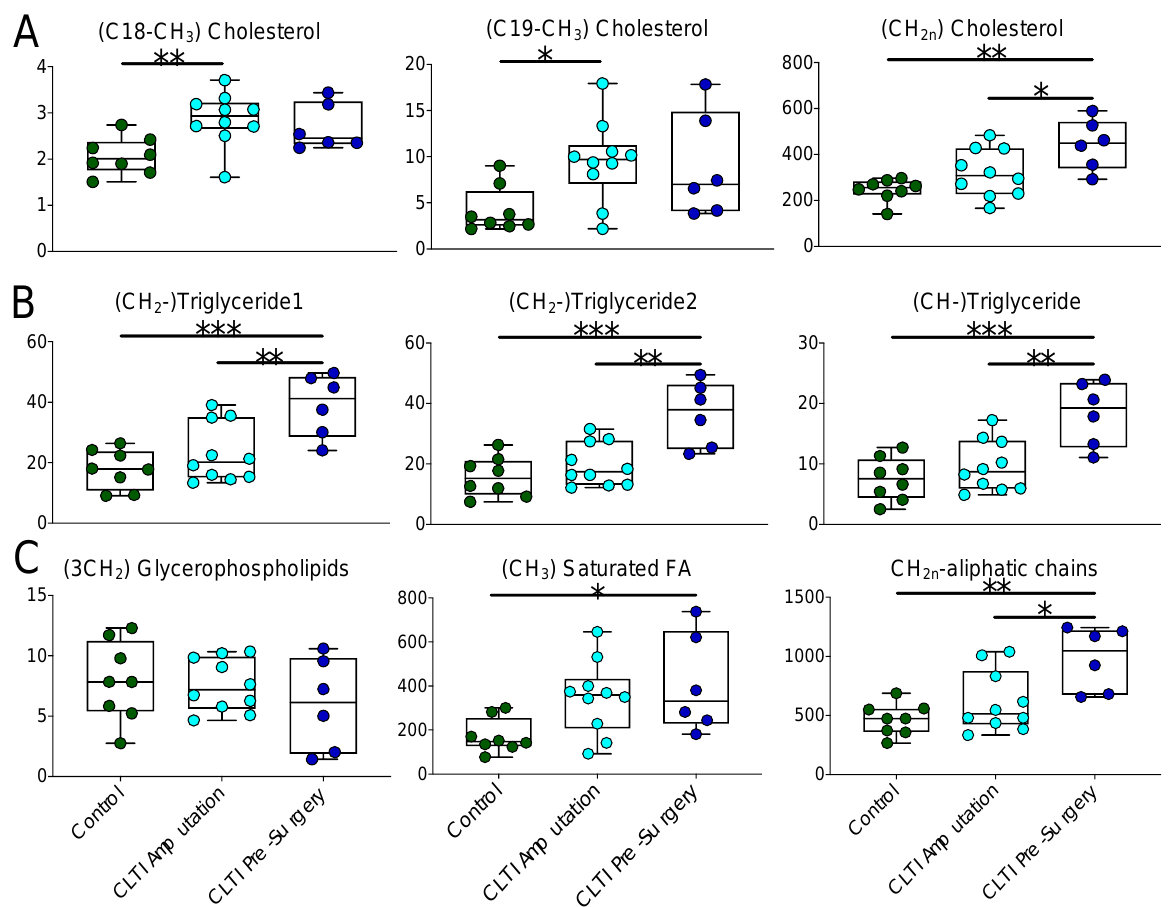
Figure 6. Aberrant Lipid Accumulation in CLTI muscle. Graphical depiction and quantitative analysis of lipid species in muscle specimens. Box and whisker plots with 95% confidence intervals are presented for quantified lipids are presented as peak areas. Panel A showed elevated cholesterols in CLTI-groups, panel B shows triglyceride concentrations, and panel C displays saturated fatty acids abundance along with similarity in glycerophospholipids amount in three groups. Analysis was performed using one-way ANOVA with Tukey’s multiple comparisons test. * p < 0.05, ** p < 0.01, *** p < 0.001.